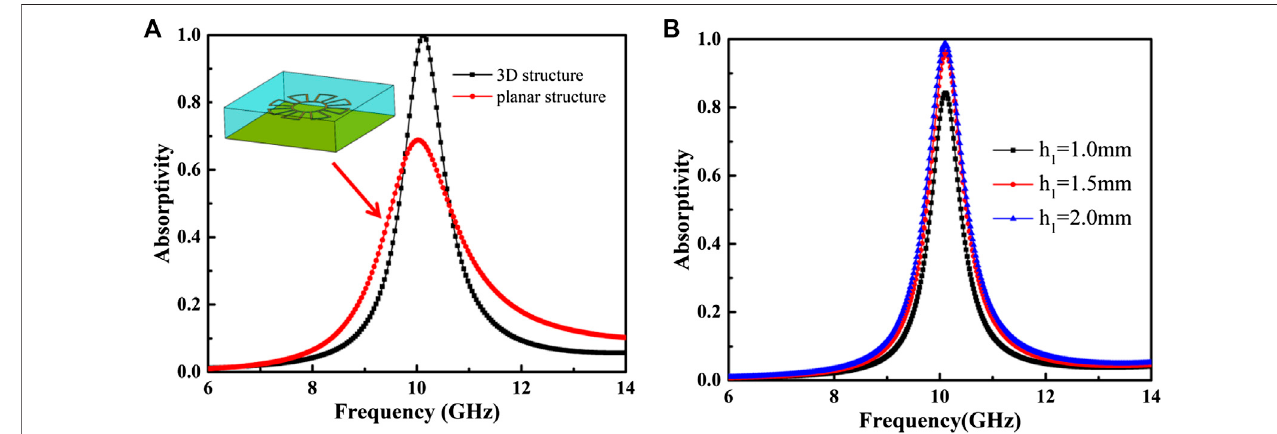
FIGURE 3 | (A) Comparison of the absorption spectrum of the proposed 3D MA and the planar design under normal incidence (B) Absorption spectrum dependency on the thickness of the standing gear-shaped structure at incidence angle of 45 ° .